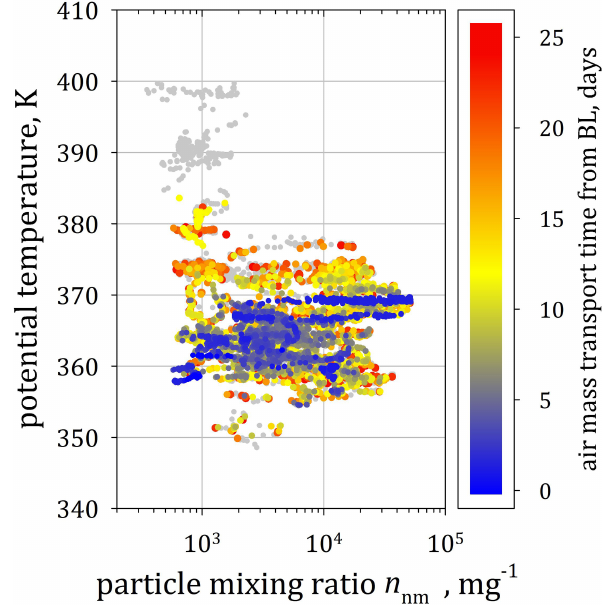
Figure 11. Vertical profile of the 1Hz resolved particle mixing ra- tio of nucleation-mode particles n nm colour-coded by the air mass transport time (days) from the boundary layer (BL). For details of ClaMS analyses, see Figs. 9 and 10.